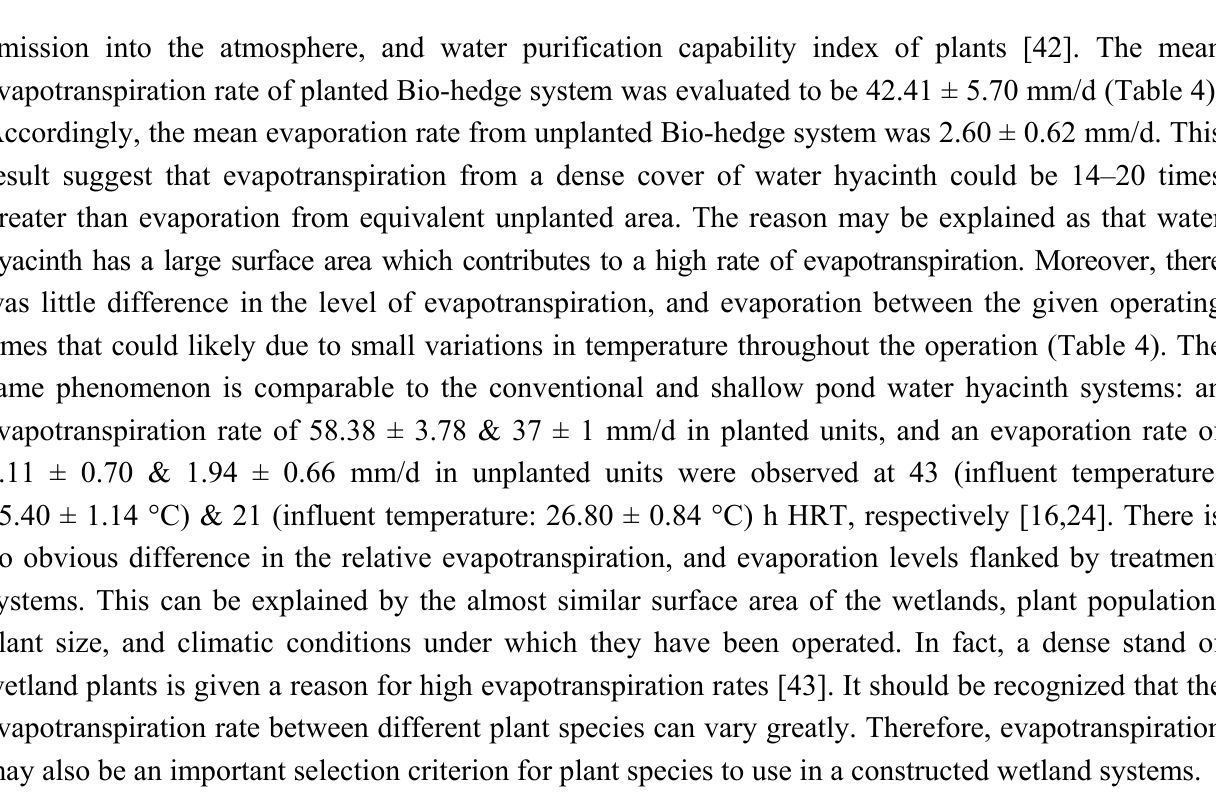
Table 4. Mean of influent temperature, evapotranspiration from planted unit,